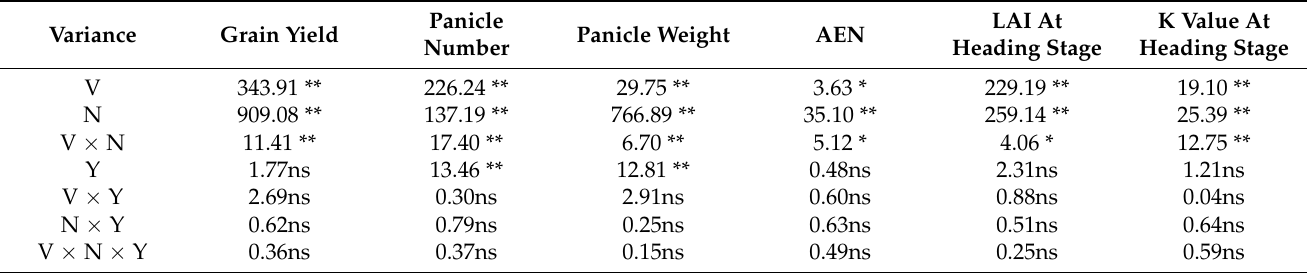
Table 3. Analysis of variance showing the significance probability of each effect for grain yield, panicles, panicle weight, AEN, LAI, and K value at heading